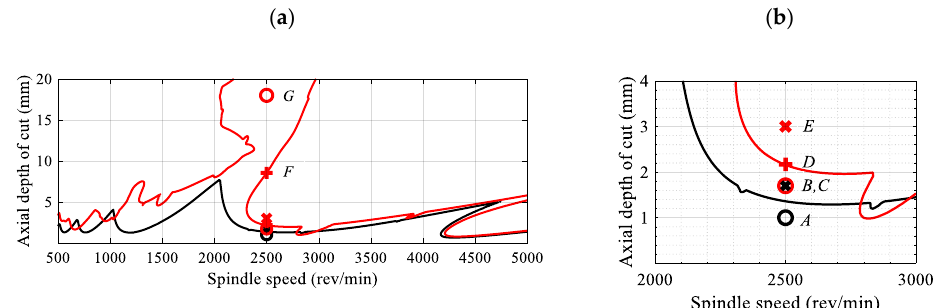
Figure 6. ( a ) Comparison of stability lobes for regular (black solid line) and multivariable (red solid line) cutters by using the third-order EMHPM and ( b ) zoom in on chosen cutting conditions for time-domain simulations. The selected points are marked as follows: unstable (cross mark), stable (circle mark) and transition (plus mark) cutting conditions.